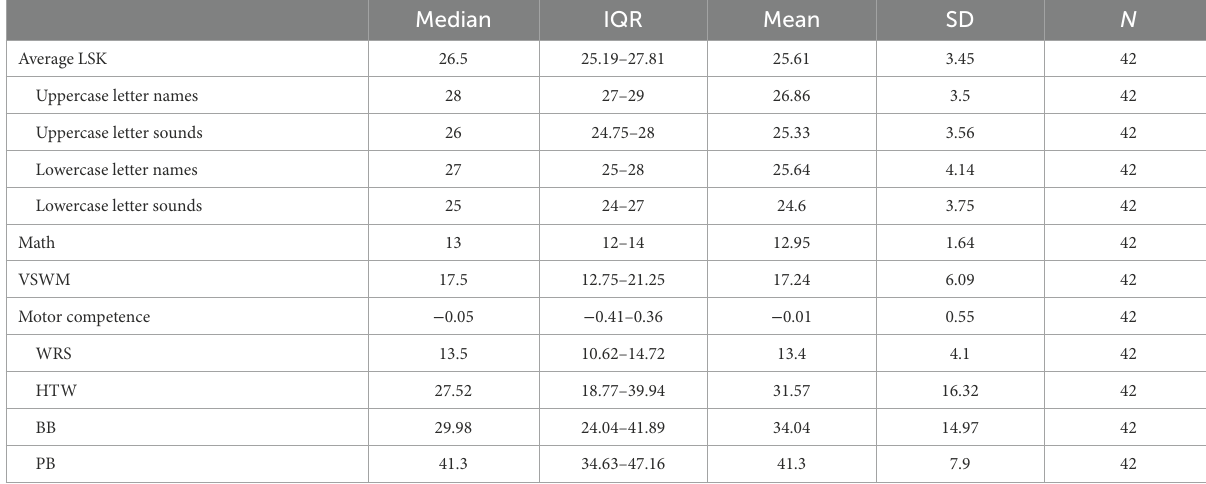
TABLE 3 Descriptive statistics of LSK, math competence, VSWM, and motor competence in first graders for